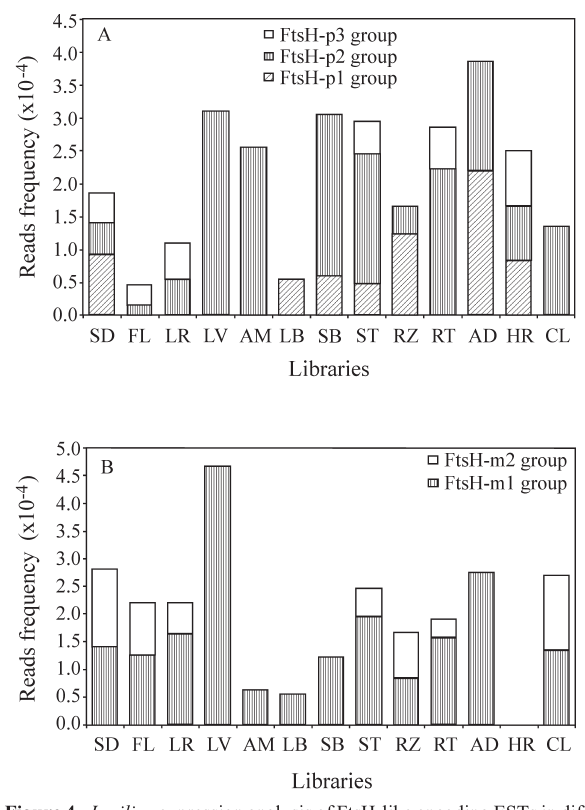
Figure 4 - In silico expression analysis of FtsH-like encoding ESTs in dif- ferent sugarcane cDNA libraries. Abbreviations: SD , seeds; FL , flowers; LR ,leafroll; LV ,etiolatedleaves; AM ,apicalmeristem; LB ,lateralbuds; SB , stem bark; ST , stem; RZ , leaf-root transition zone; RT , root; AD , roots from plantlets infected with Gluconacetobacter diazotroficans growing in vitro ; HR , roots from plantlets infected with Herbaspirillum rubrisubalbicans growing in vitro ; CL